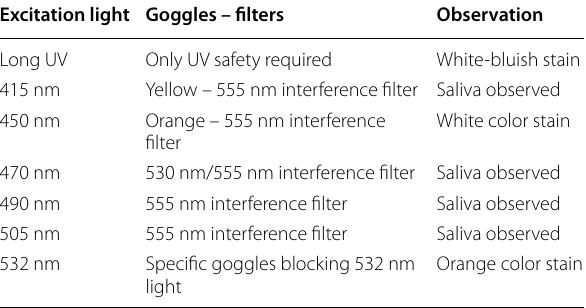
Table 2 Excitation wavelength coupled with suitable goggles Excitation light Goggles – filters